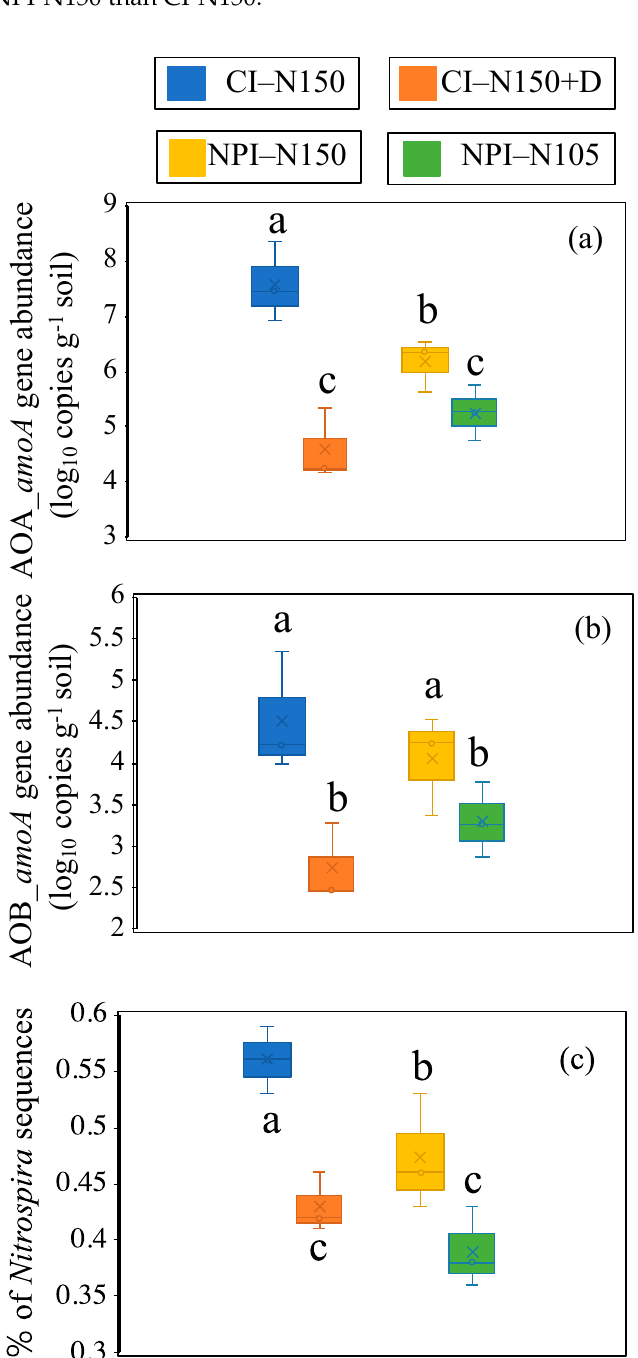
Figure 5. Abundance of AOA and AOB amoA genes, Nitrospira under different irrigation and N treatments. ( a ) AOA_ amoA gene abundance; ( b ) AOB_ amoA gene abundance; ( c ) % of Nitrospira sequences. CI is conventional irrigation, and NPI is negative pressure irrigation. N150: 150 kg N ha − 1 , N105: 105 kg N ha − 1 ; D is DCD addition. All of the data are the mean of three replicates ± SE, and different letters indicate significant differences between the treatments ( p < 0.05) by Duncan’s tests.